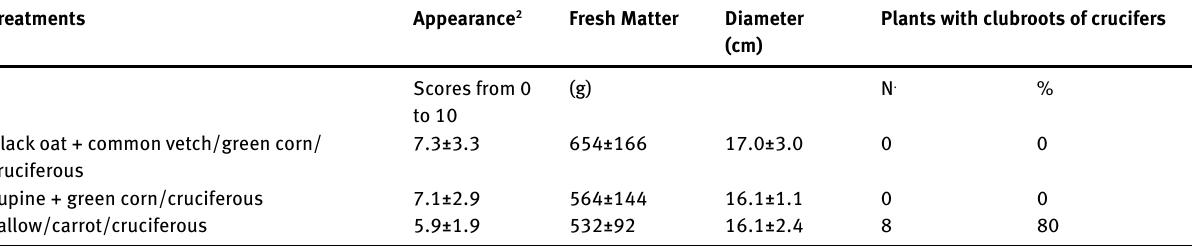
Table 2. The attributes of cauliflower shoots grown in soil subjected to different plant successions and the incidence of clubroot of crucifers in the third agricultural year